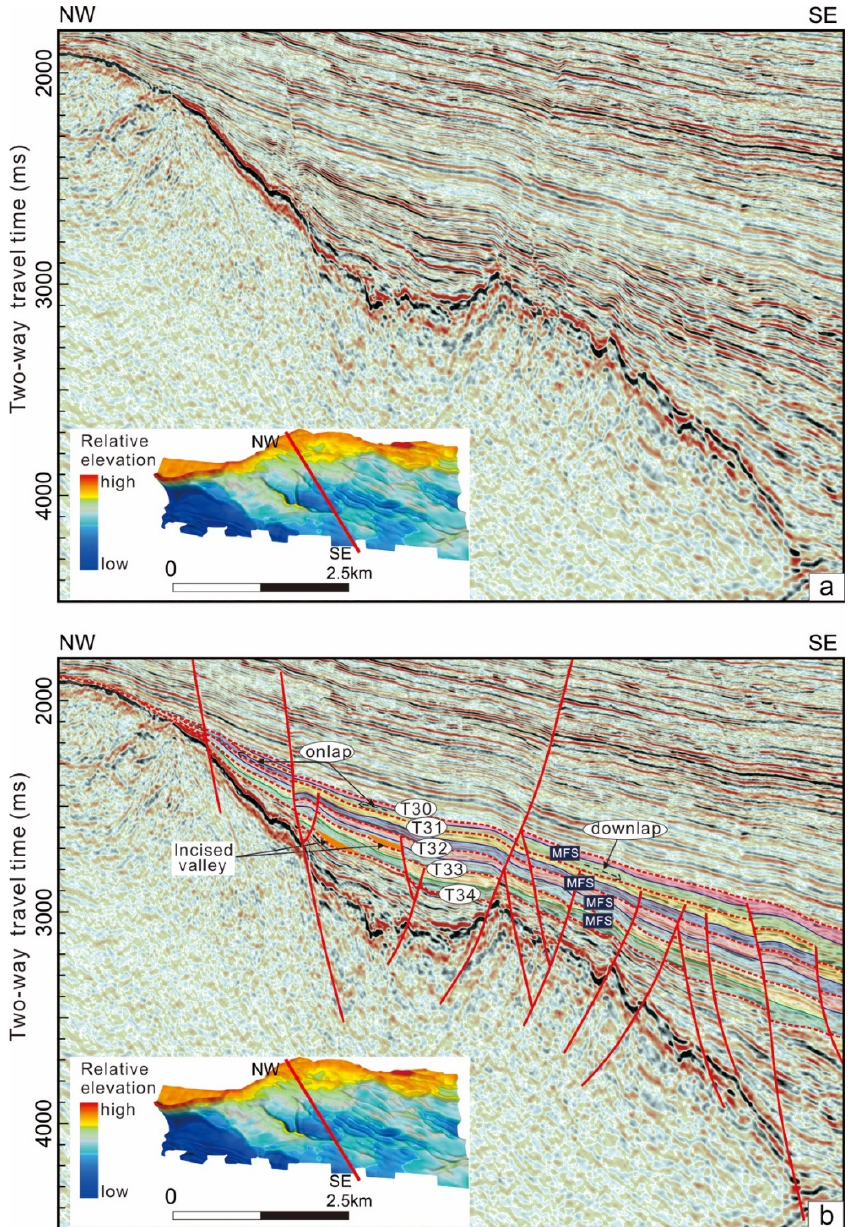
Figure 3. ( a ) Uninterpreted NW–SE seismic profile and ( b ) identification of sequence boundaries and division of sequence units in this seismic profile. The inset shows the location of the seismic profile in the Xihu Sag.